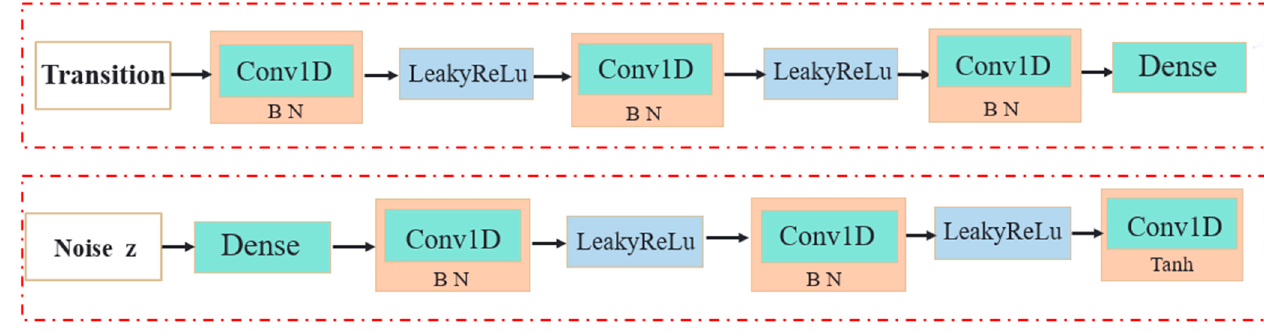
Figure 1. The architecture of the generator (down) and discriminator (up) .